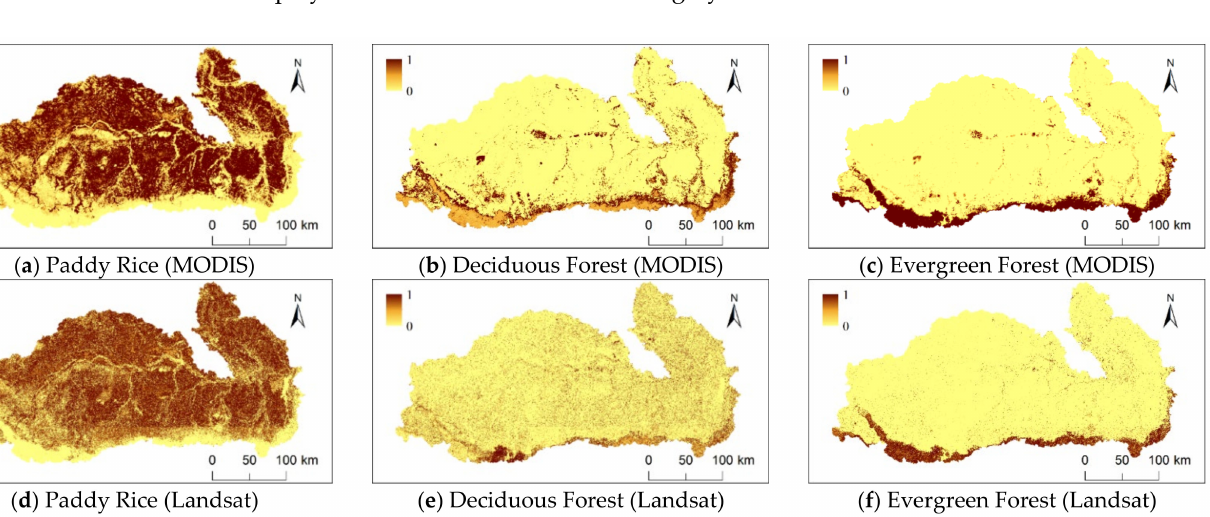
Figure A1. Memberships of three selected land covers from MODIS and Landsat data in the Mun River Basin. The membership value is between 0 and